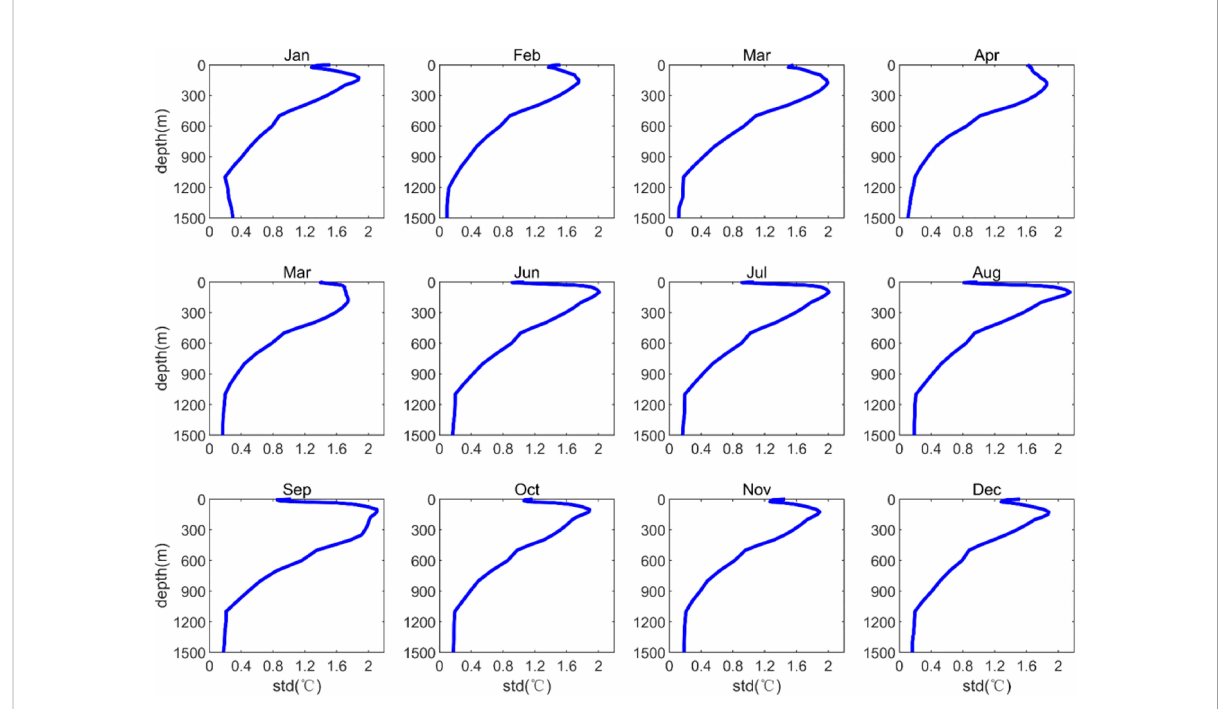
FIGURE 3 Vertical distribution of monthly static climatic temperature fi eld standard deviations in the northern South China Sea.